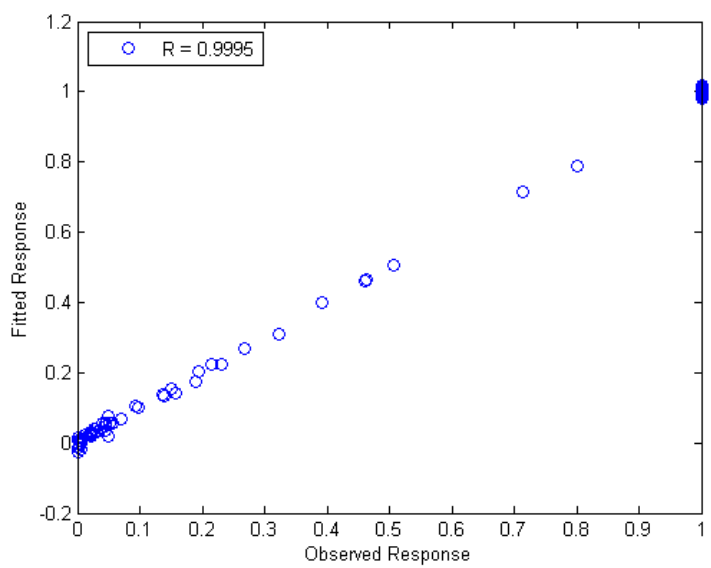
Figure 5. Fitted response vs. observed response for the Partial Least Squares (PLS) regression.